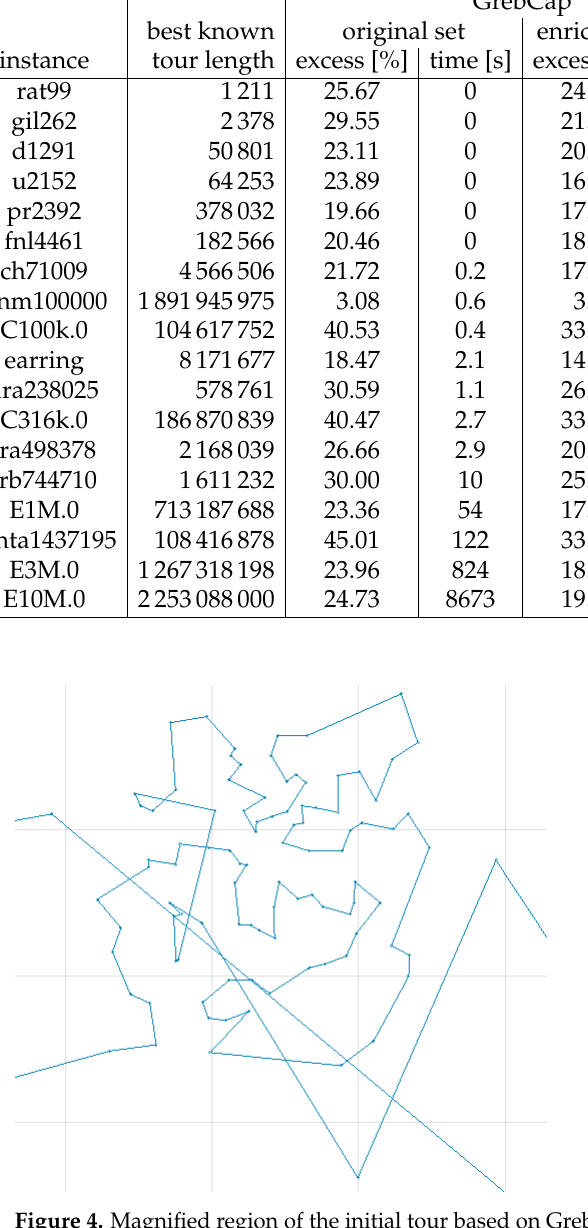
Figure 4. Magnified region of the initial tour based on GrebCap+ for C100k.0 showing the initial tour with unfavourable long